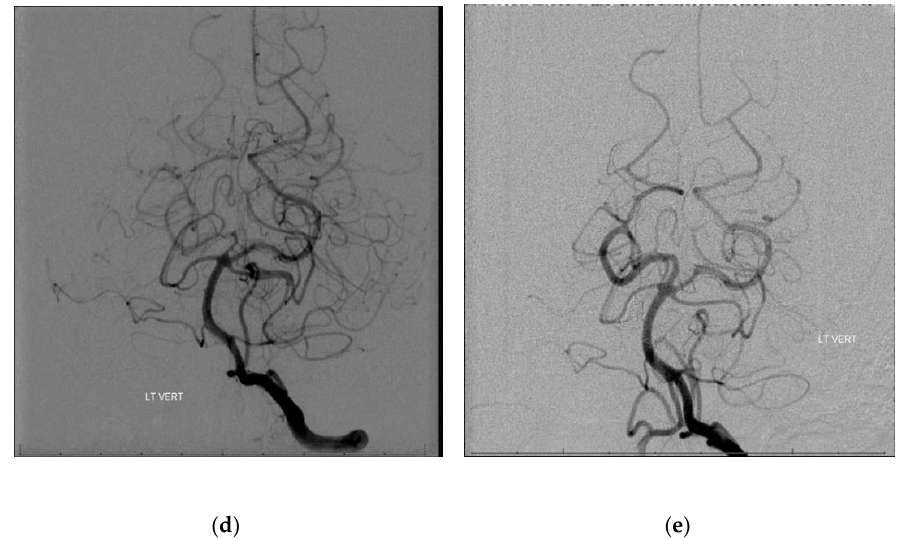
Figure 1. Illustrative case. ( a – c ) 5 mm posterior communicating artery aneurysm with a dominant posterior communicating artery treated with coils and one Pipeline stent showing persistent obliteration of aneurysm on 3 year follow-up as well as decrease in diameter of the dominant PcomA. ( d , e ) See increase in diameter of the ipsilateral (right) P1 segment of the posterior cerebral artery.